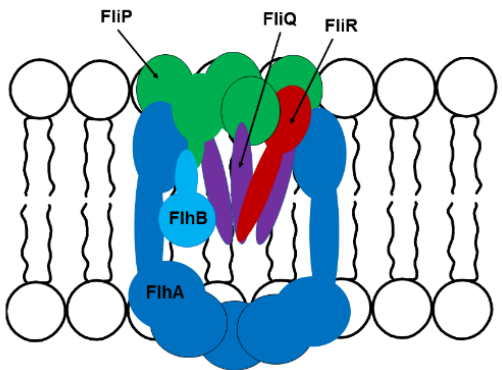
Figure 3. Schematic illustration of the flagellar CORE apparatus which consists of FliP, FliQ, FliR, FlhB, and FlhA (5:4:1:1:9) transmembrane proteins. The chaperone FliO has not been shown.